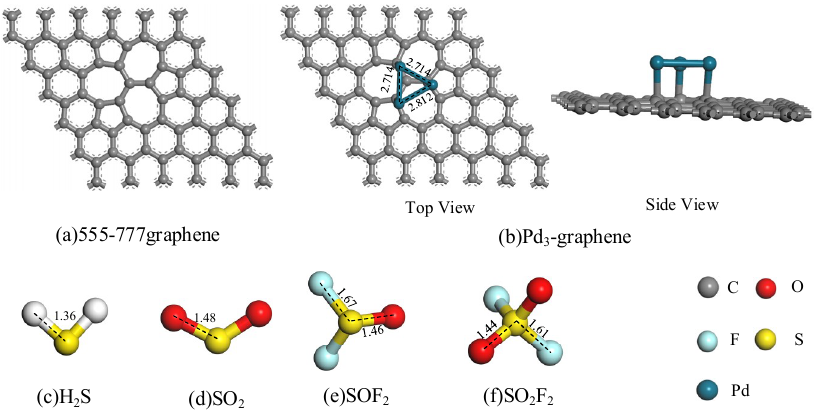
Figure 1. Optimized structures of intrinsic 555–777 graphene, Pd 3 -graphene and gas molecules (distance in Å). © 2020 IEEE.